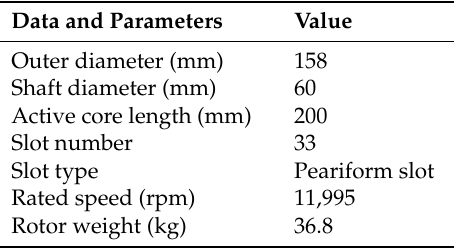
Table 1. Main structure parameters of rotor.